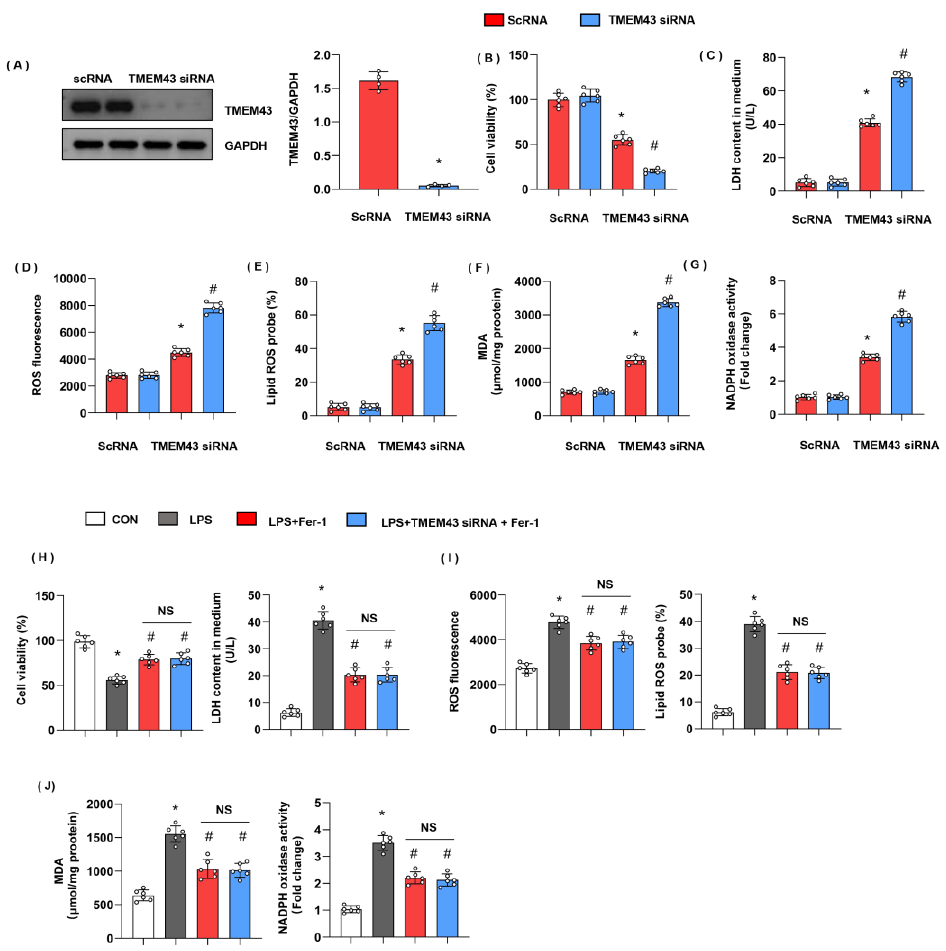
Figure 8. TMEM43 knockdown in vitro deteriorates LPS-induced cell injury. H9c2 cells were trans- fected with TMEM43 siRNA. ( A ) Protein level of TMEM43 in H9c2 cells transfected with TMEM43 siRNA ( n = 4). ( B ) Cell viability in each group ( n = 6). ( C ) LDH level in H9c2 cells in each group ( n = 6). ( D ) ROS level in H9c2 cells in each group ( n = 6). ( E ) Lipid ROS level in H9c2 cells in each group ( n = 6). ( F , G ) MDA and NADPH oxidase activity in each group ( n = 6). * p < 0.05 vs. scRNA/CON group. # p < 0.05 vs. scRNA/LPS group. ( H – J ) H9c2 cells were transfected with TMEM43 siRNA